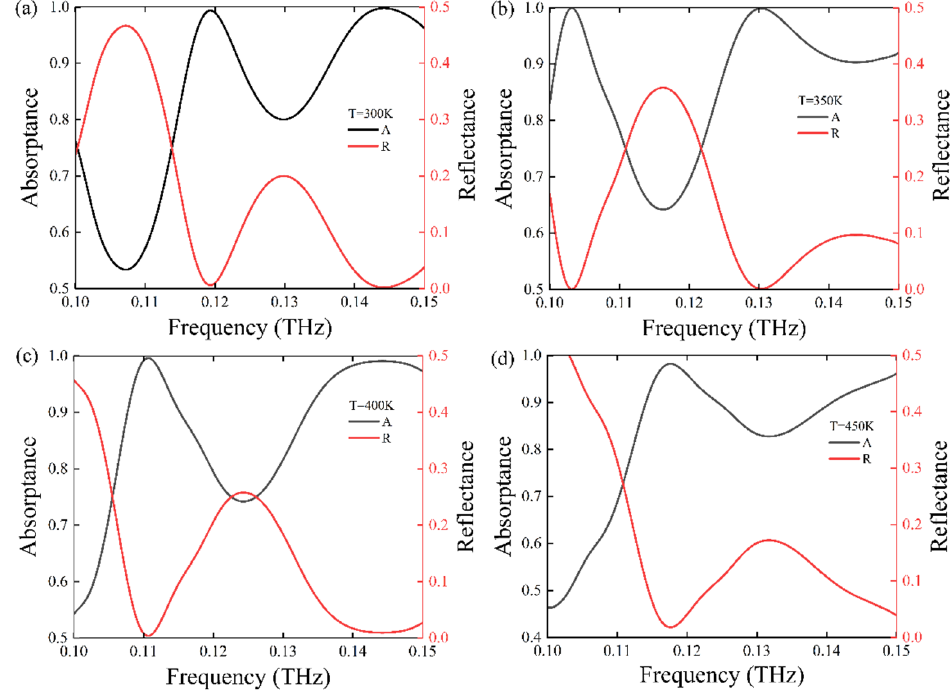
Figure 9. The absorptance and reflectance spectrum at a frequency ranging from 0.1 to 0.15 THz under different temperatures: ( a ) T = 300 K, ( b ) T = 350 K, ( c ) T = 400 K, and ( d ) T = 450 K.